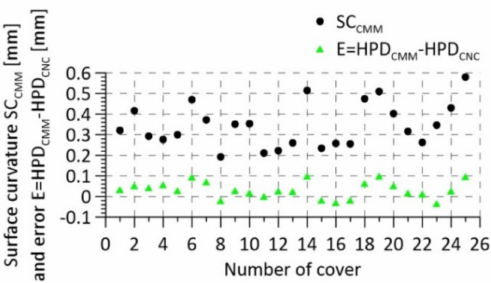
Figure 10. Curvature of the reference surface of the cover in combination with the di ff erence of measurement results on CMM and CNC machine.